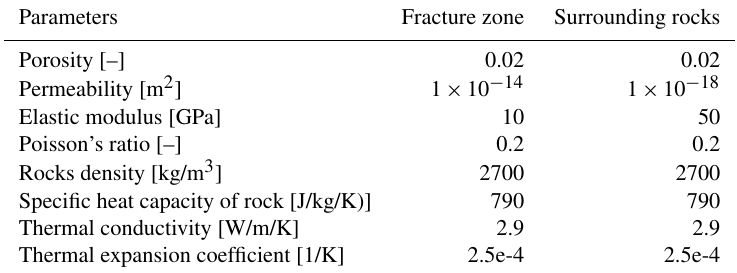
Figure 1. Geometry and scenarios for the numerical simulation (Scenario 1: single fracture zone; Scenario 2: two parallel fracture zones with tight spacing; Scenario 3: two parallel fracture zones with loose spacing; Scenario 4: three parallel fracture zones). Table 1. Parameters used in